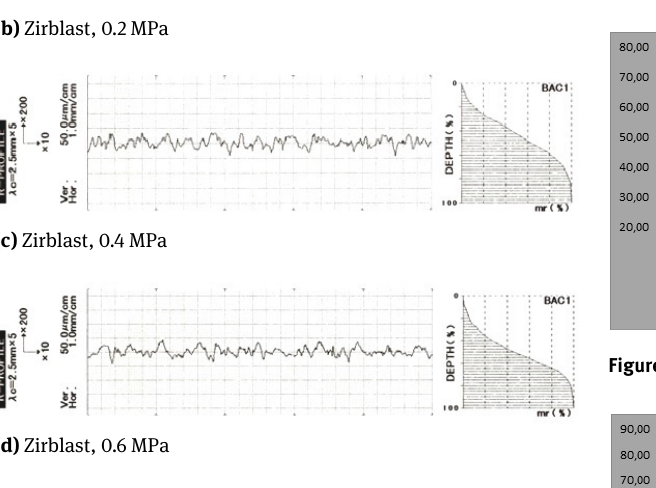
Figure 4: The effect of pressure on the value of the parameter Ra.